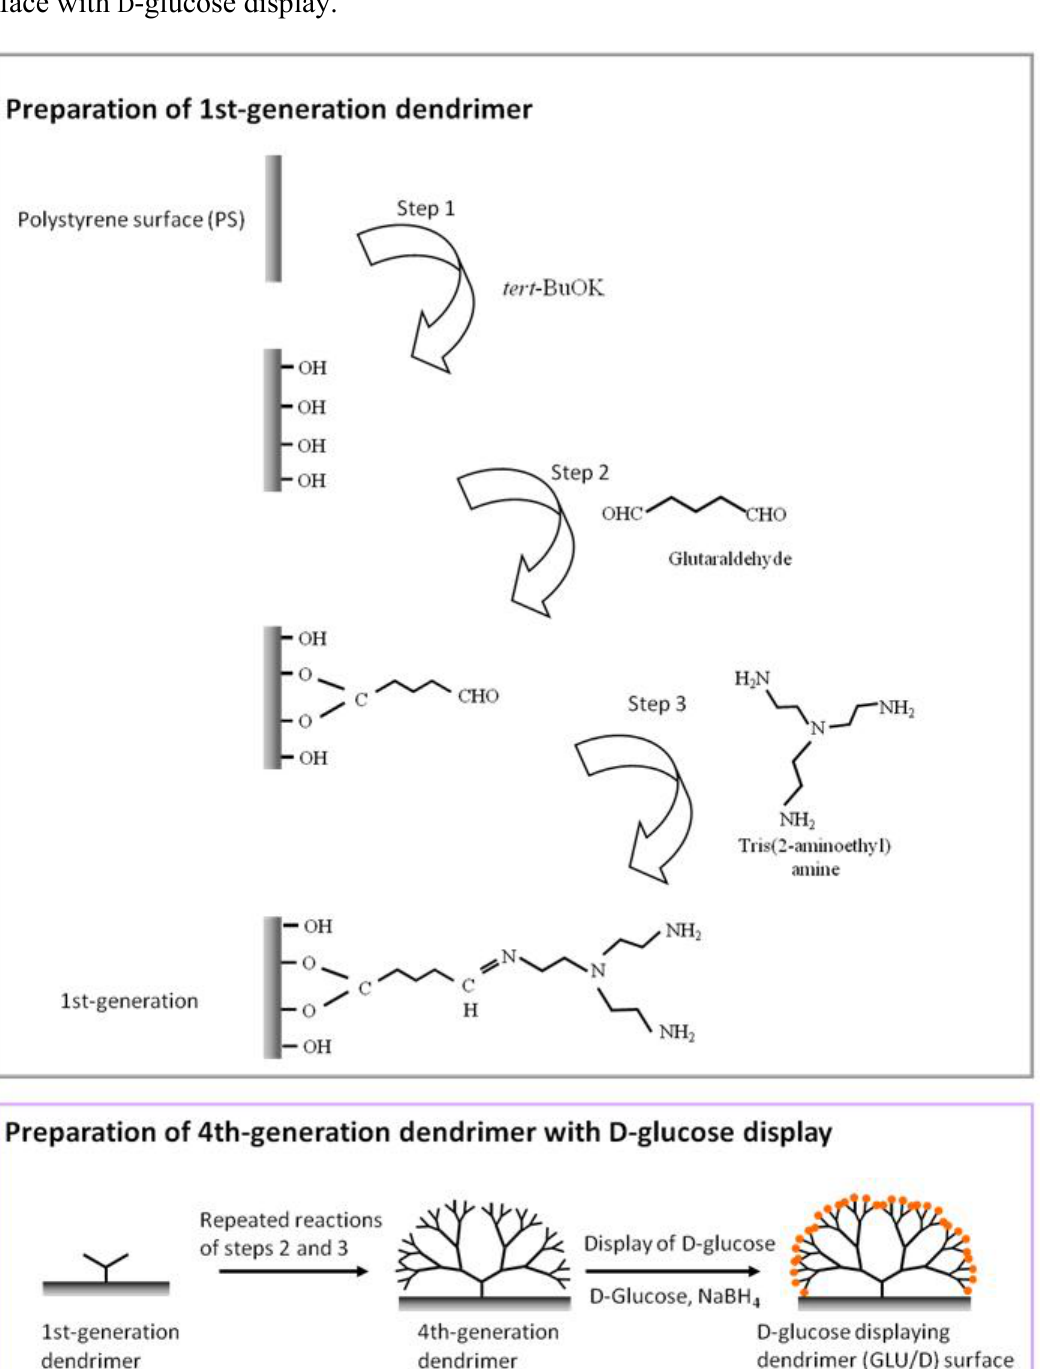
Figure 1. Schematic illustration showing procedure for preparation of dendrimer-immobilized surface with D -glucose